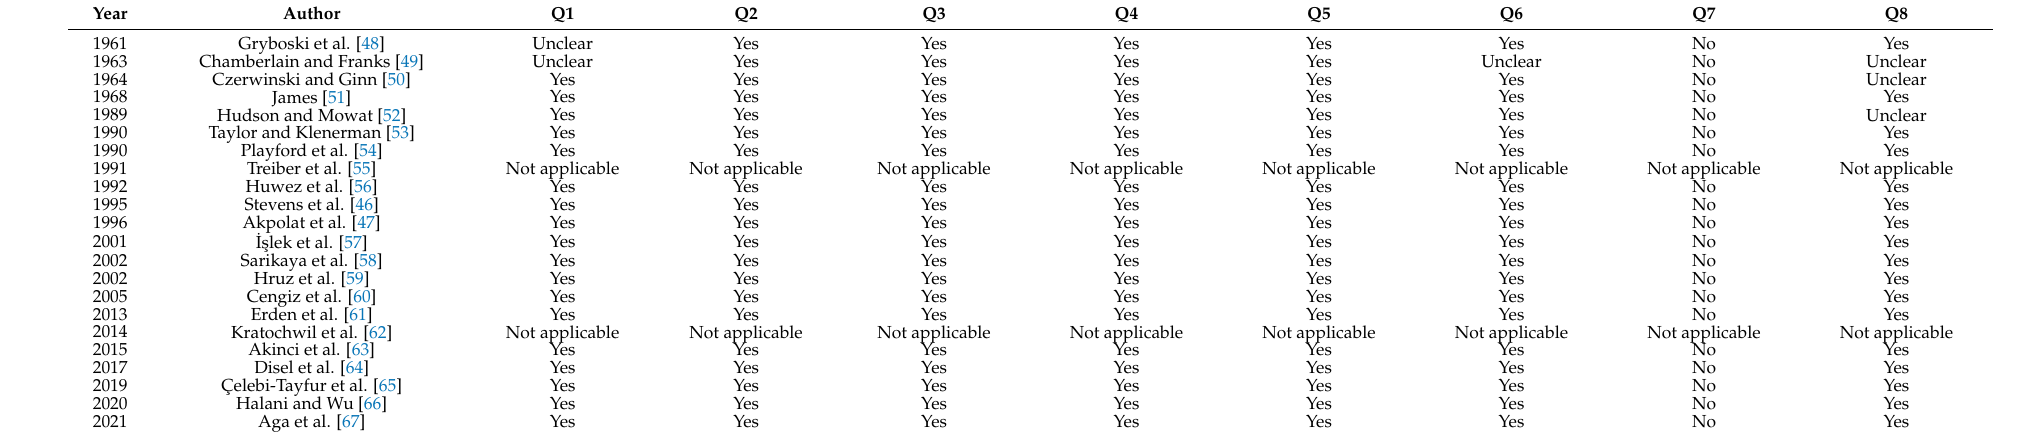
Table 2. Risk of bias assessment of the included